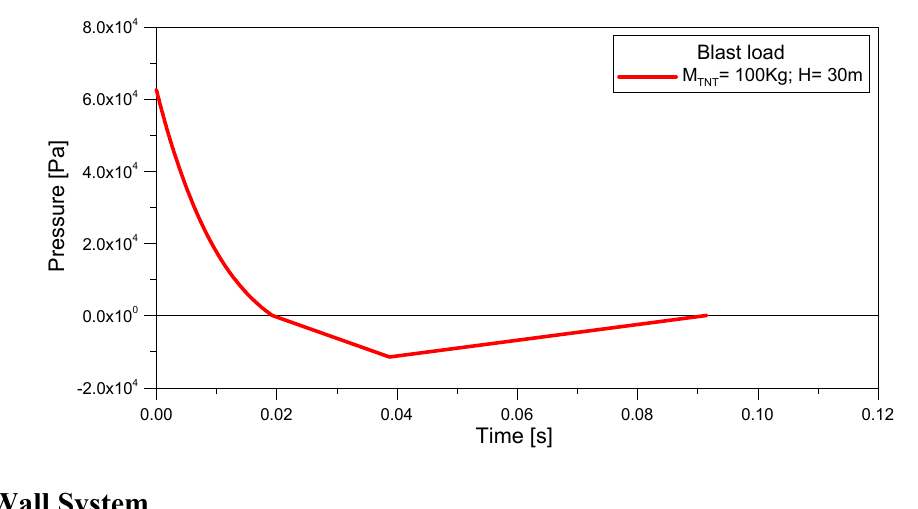
Figure 1. Time varying-reflected overpressure function for high-level air blast load (M = 100 kg, H = 30 TNT